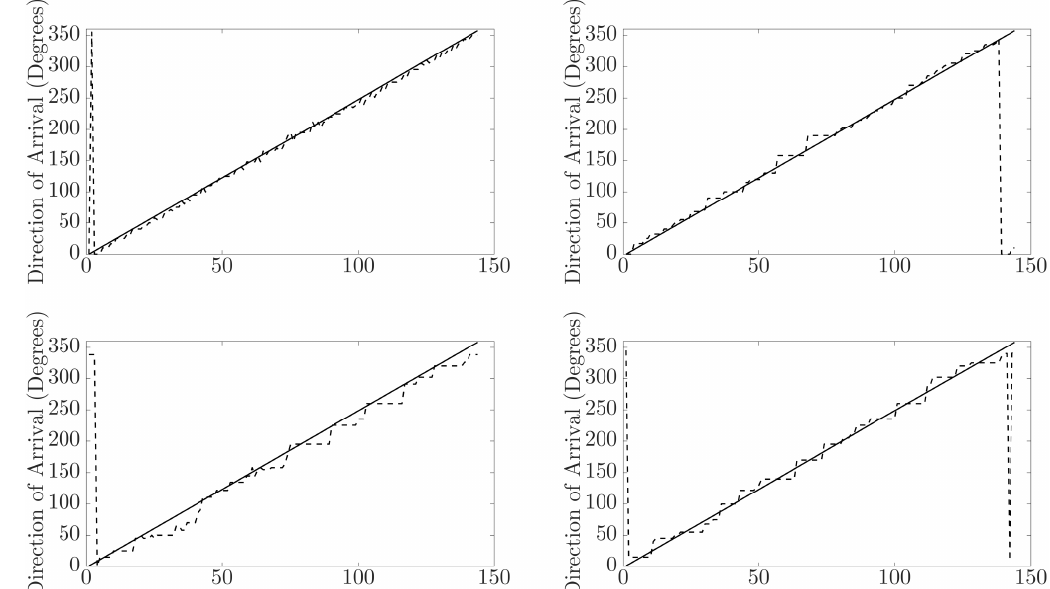
Figure 11. Plots of neural network predicted direction of arrival (dotted black line) vs. expected direction of arrival (solid line). The top left plot is for the KEMAR direct sound; the top right plot is for the KU100 direct sound; the bottom left is for the KEMAR reflection; and the bottom right is for the KU100